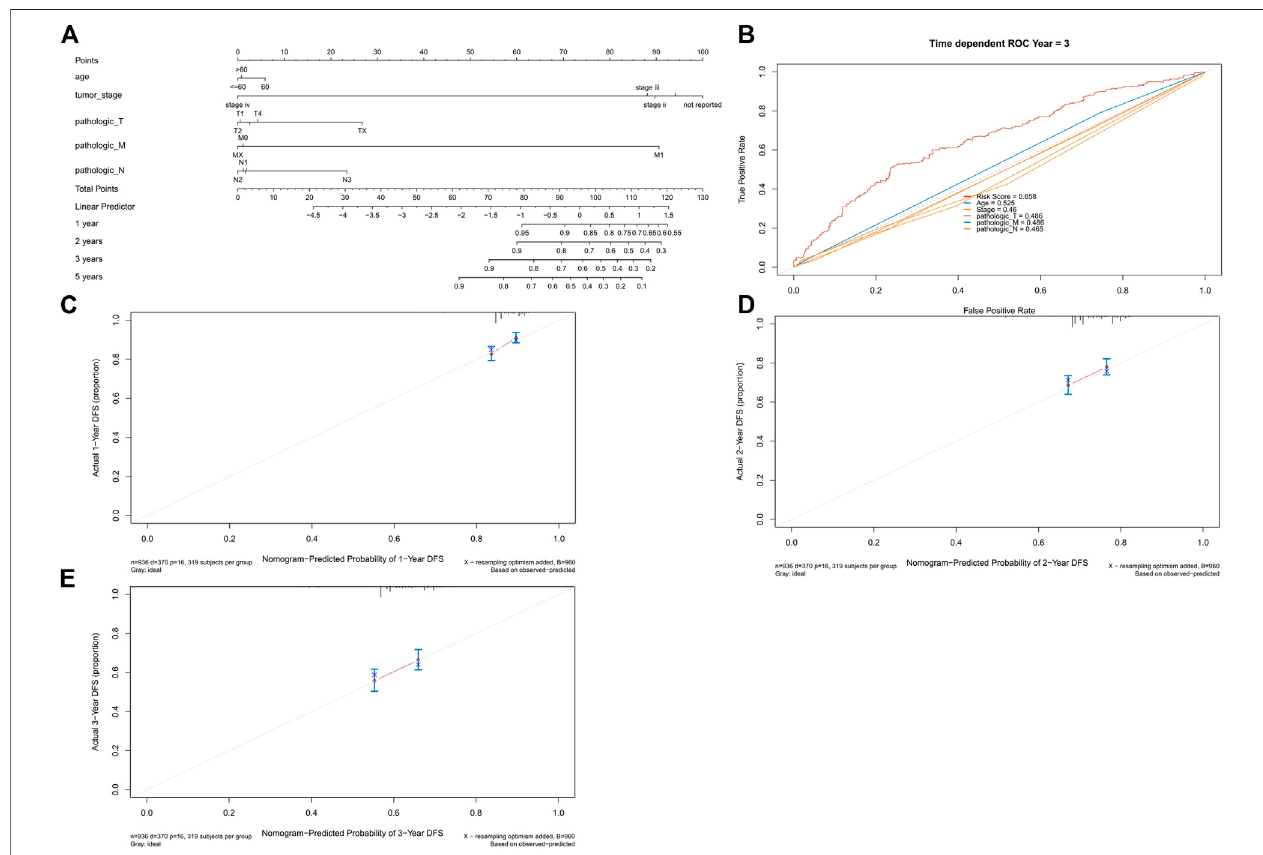
FIGURE12| Nomogramandcalibrationplots. (A) Nomogramofage,tumorstage,andTNMstage. (B) ROCcurveofriskscore,age,tumorstage,andTNMstage. (C) 1-year calibration plot. (D) 2-years calibration plot and (E) 3-years calibration